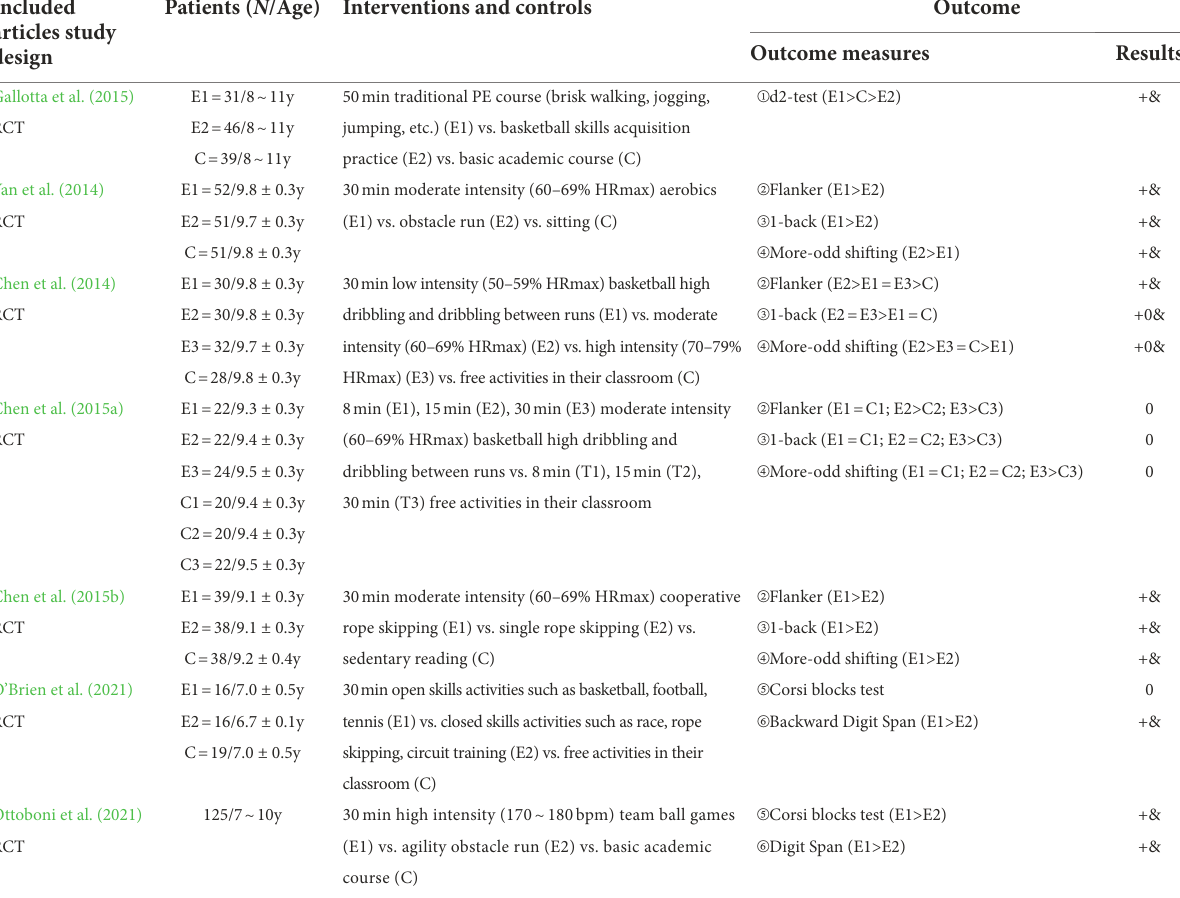
TABLE 1 Comparative study of acute interventions of motor skills on the cognition of children and adolescents. Included articles